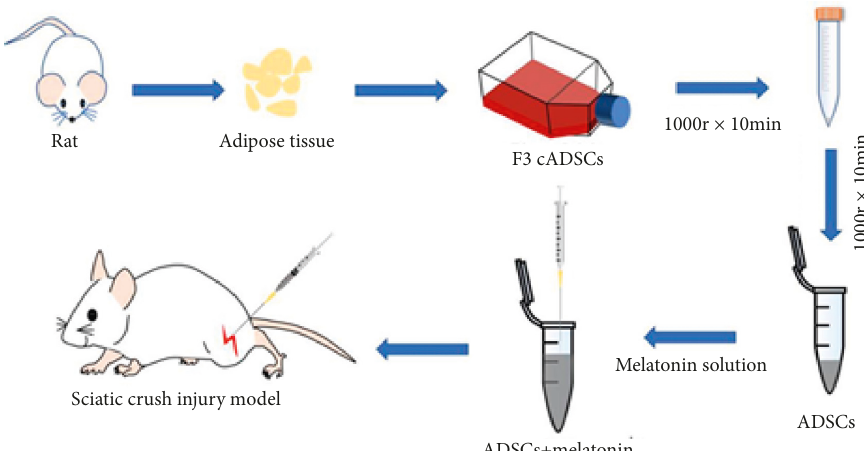
Figure 1: Drug allocation process.